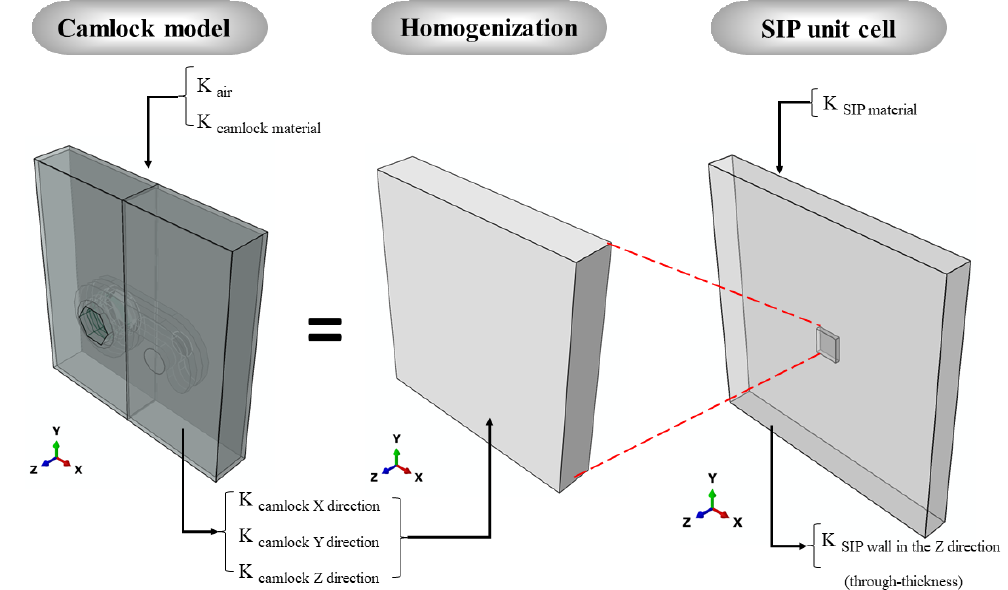
Figure 4. Two-scale finite element homogenization methodology.